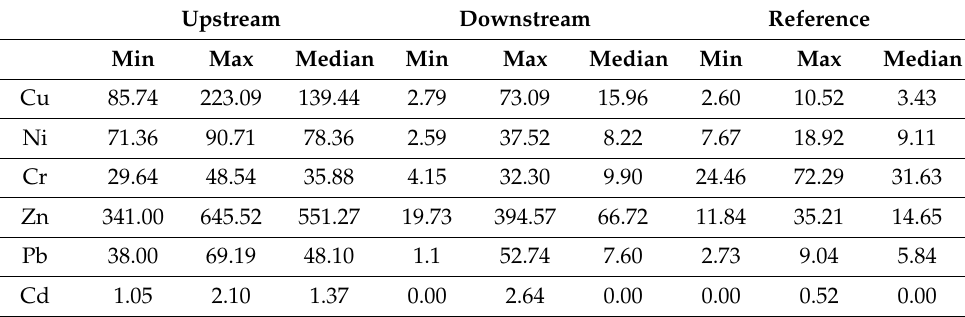
Table 5. Basic statistical results of the heavy metal analyses in the sediment near the hydroelectric power plant on the ´Sl˛eza